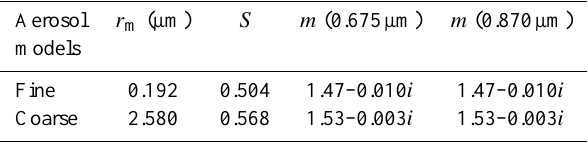
Detailed parameters of fine model and coarse model